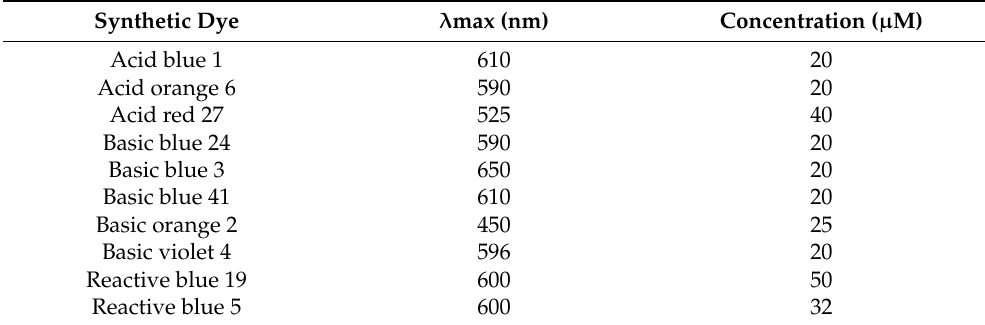
Table 2. Concentration and λ max of synthetic dyes used in photocatalytic assays using AgNPs obtained using different mycelia-free aqueous extract